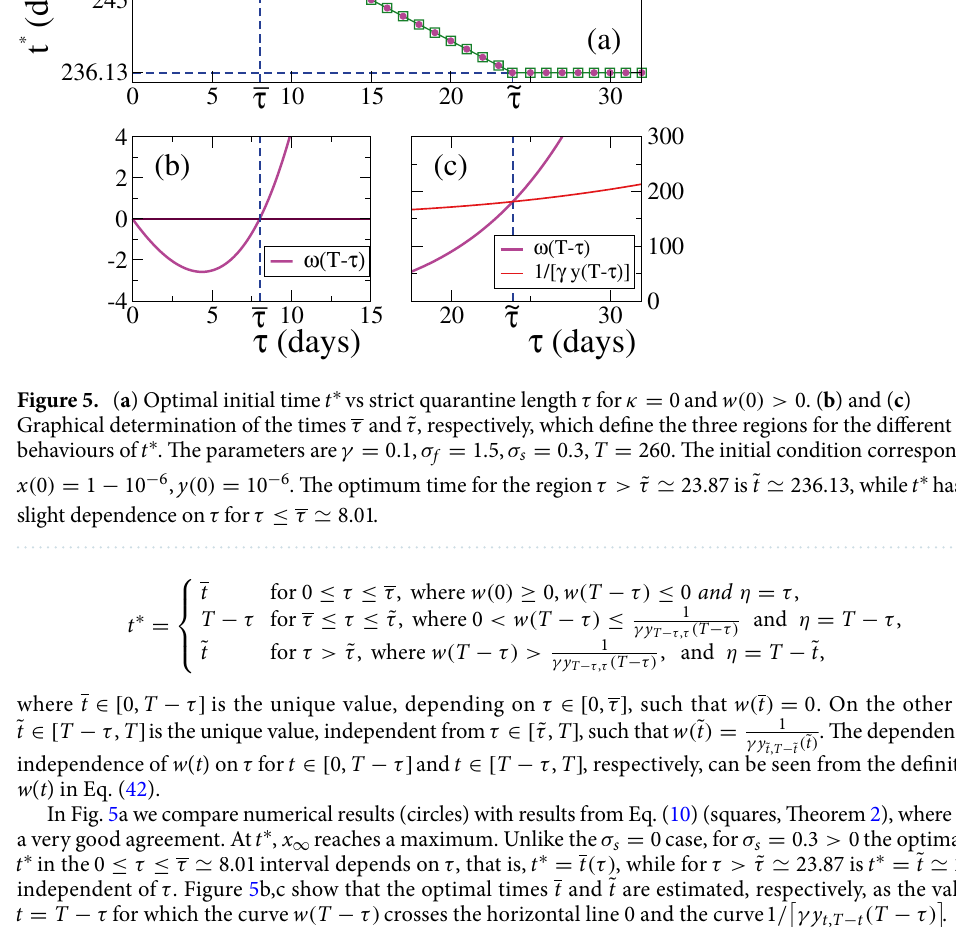
Figure 6 is analogous to Fig. 4 for the σ s = 0 case, and depicts the three different behaviours of t ∗ . Curves are similar to those of σ s = 0 , where the main difference is that for σ s = 0.3 > 0 the trajectory of the system within the strict quarantine in the x − y space is described by a diagonal line (see inset of top-right panel), given that σ s is larger than zero and thus x ( t ) decreases in this period. At the optimum time t ∗ , y ( t ) drops to the lowest level curve in the interval [ t , t + η ] (pink curves).